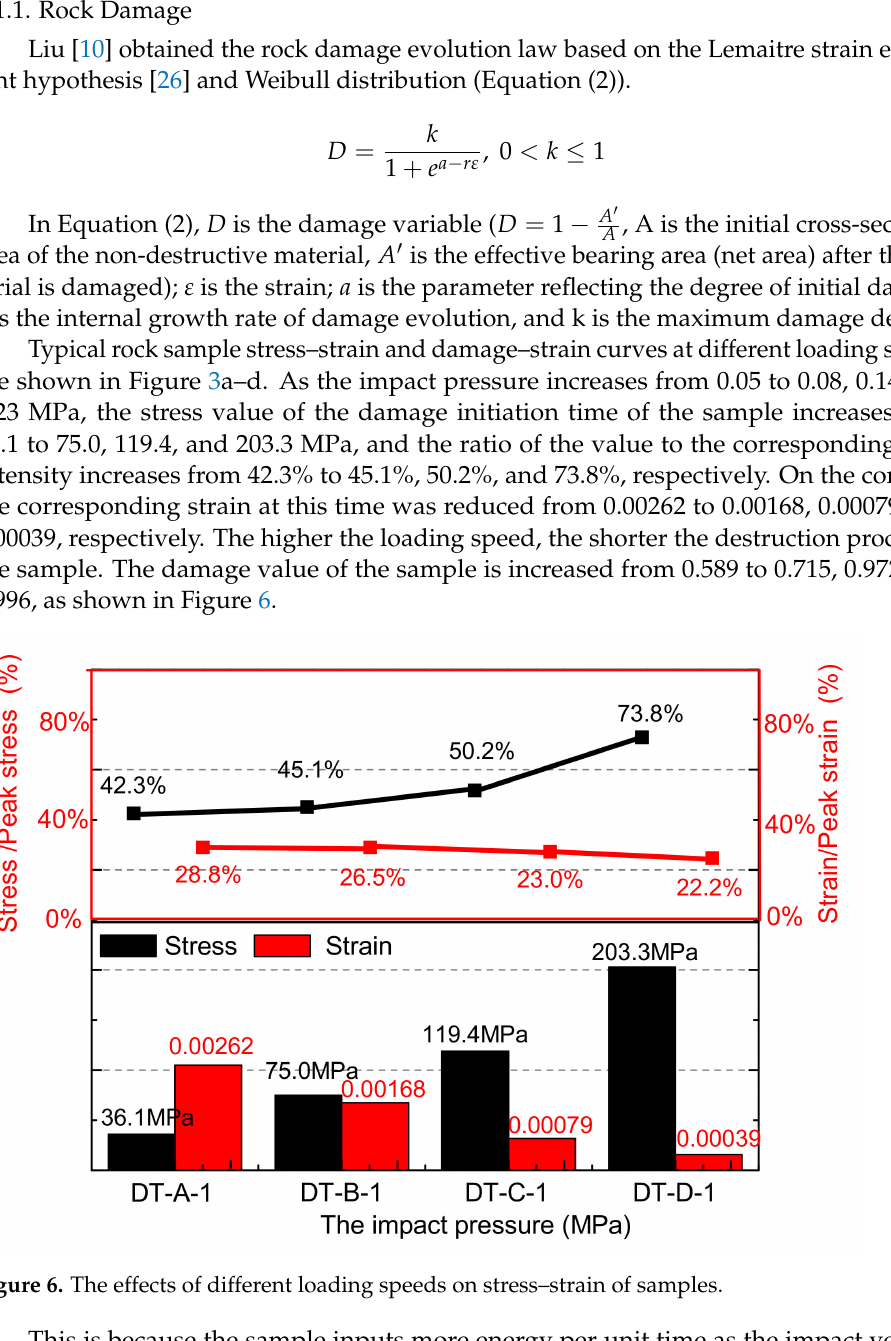
from one peak to the peak